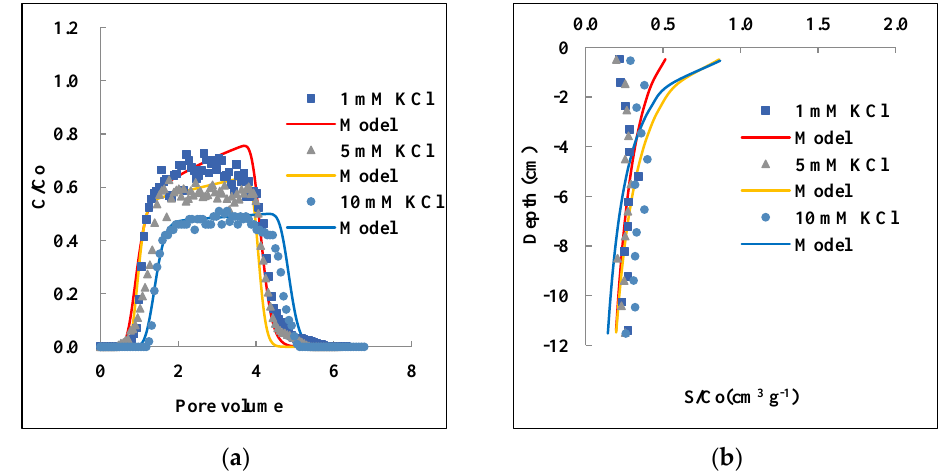
Figure 2. Effect of ionic strength 1, 5, and 10 mM on the transport and retention of PAM@MNP in saturated QS: Observed and modeled BTCs ( a ) and RPs ( b ). Initial concentration: 1 mg L −1 ; grain size: 607 μm, Darcy velocity: 0.29– 3.0 cm min −1 .